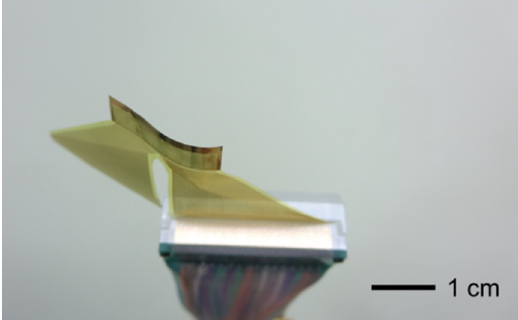
Figure 17. Photograph of the plastic deformation of the connection during the bending test.